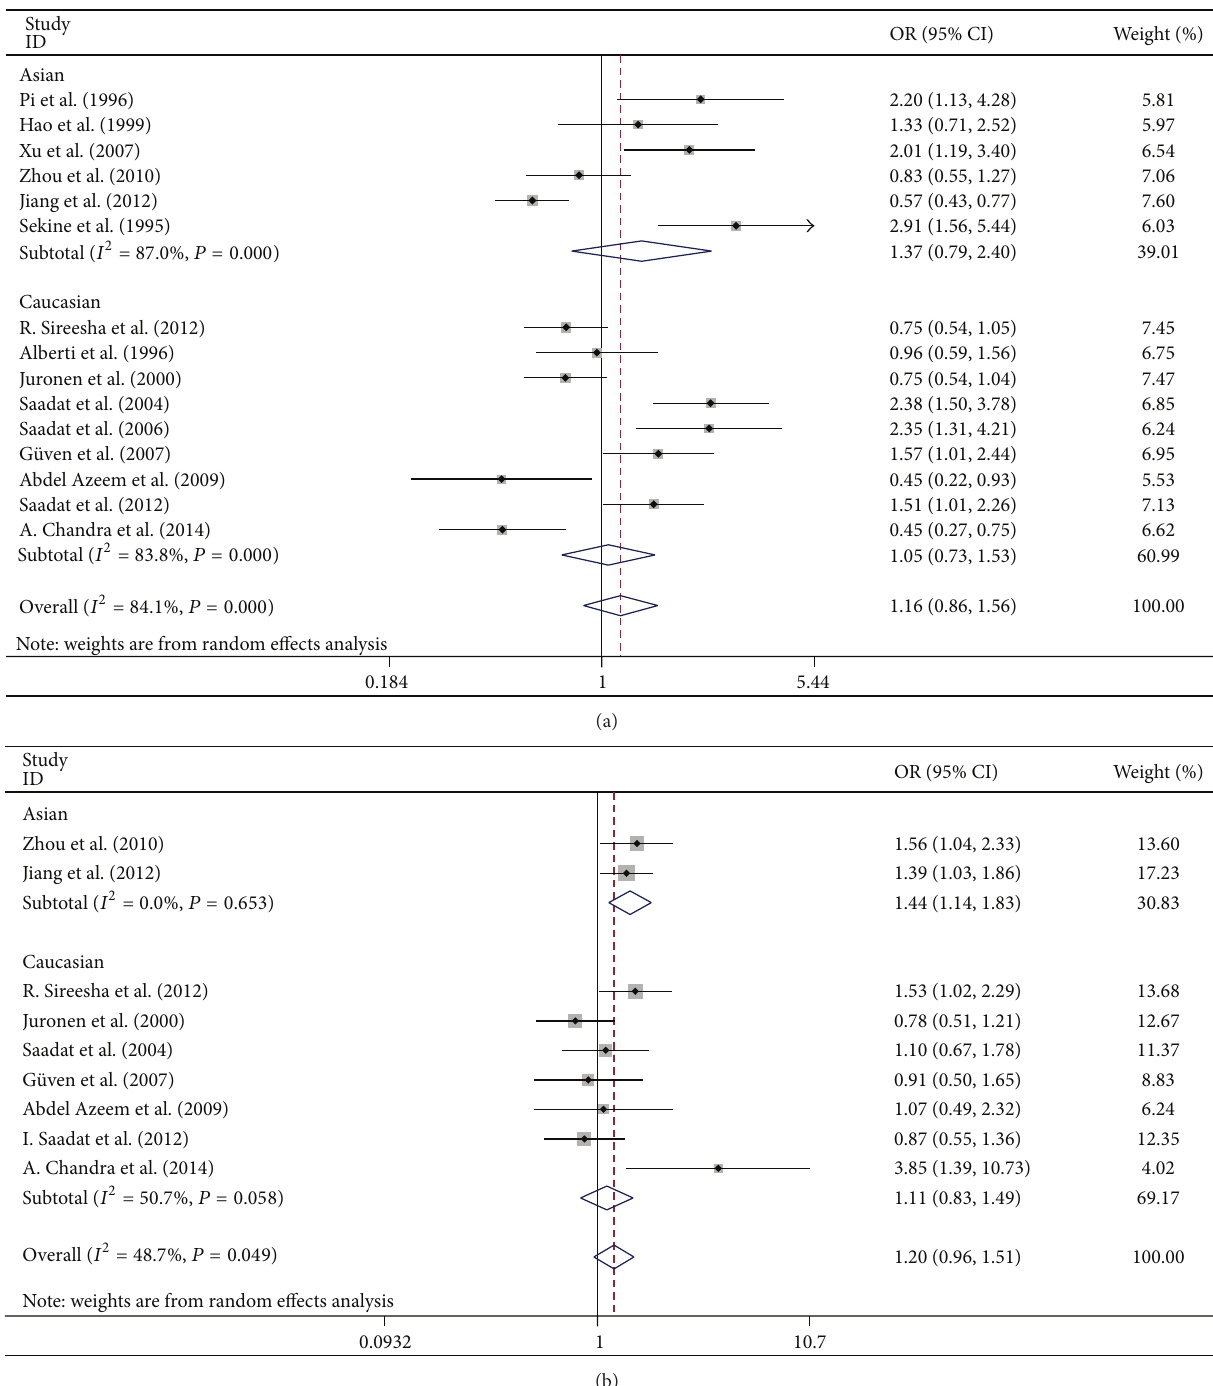
Figure 3: Ethnicity-based subgroup analysis of the correlation between GSTM1/T1 null genotype and age-related cataract (ARC). (a) Ethnicity-based subgroup analysis of the association between GSTM1 null genotype and ARC. (b) Ethnicity-based subgroup analysis of the association between GSTT1 null genotype and